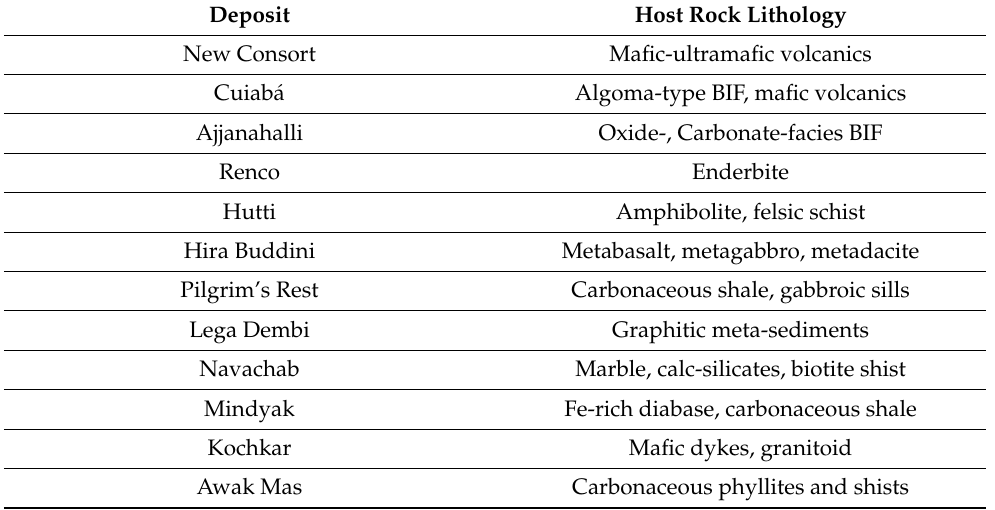
Table 3. Host rocks to the gold